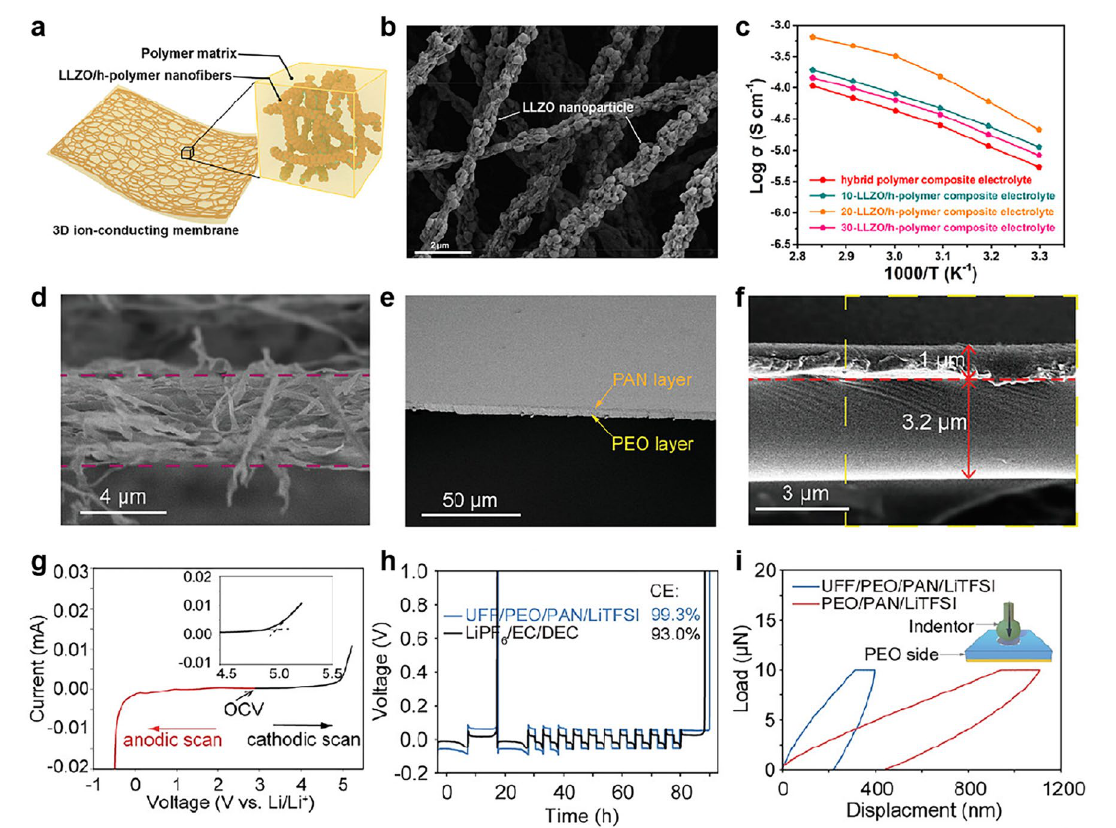
Fig. 6 a Schematic diagram of CSEs with LLZO/h-polymer nanofibers. b SEM image of 3D ion-conducting nanofiber networks. c Arrhenius curves of CSEs with polymer nanofibers and CSEs with LLZO-polymer nanofibers with different LLZO contents. a–c Reproduced with permis- sion [139]. Copyright 2021, American Chemical Society. d Cross-sectional SEM image of the as-spun UFF. e Cross-sectional SEM image of the double-layer UFF/PEO/PAN/LiTFSI CSEs. f Cross-sectional SEM enlarged image of the UFF/PEO/PAN/LiTFSI CSEs. g The electrochemical window of the UFF/PEO/PAN/LiTFSI electrolyte. The inset is a magnified image of the onset of the oxidation process. OCV, open circuit volt- age. h CE measurement of Li metal (known as Aurbach CE measurement) proposed by Aurbach in Li–Cu half cells using different electrolytes in Li–Cu half cells using different electrolytes. i Nanoindentation test on the PEO side of the UFF/PEO/PAN/LiTFSI and